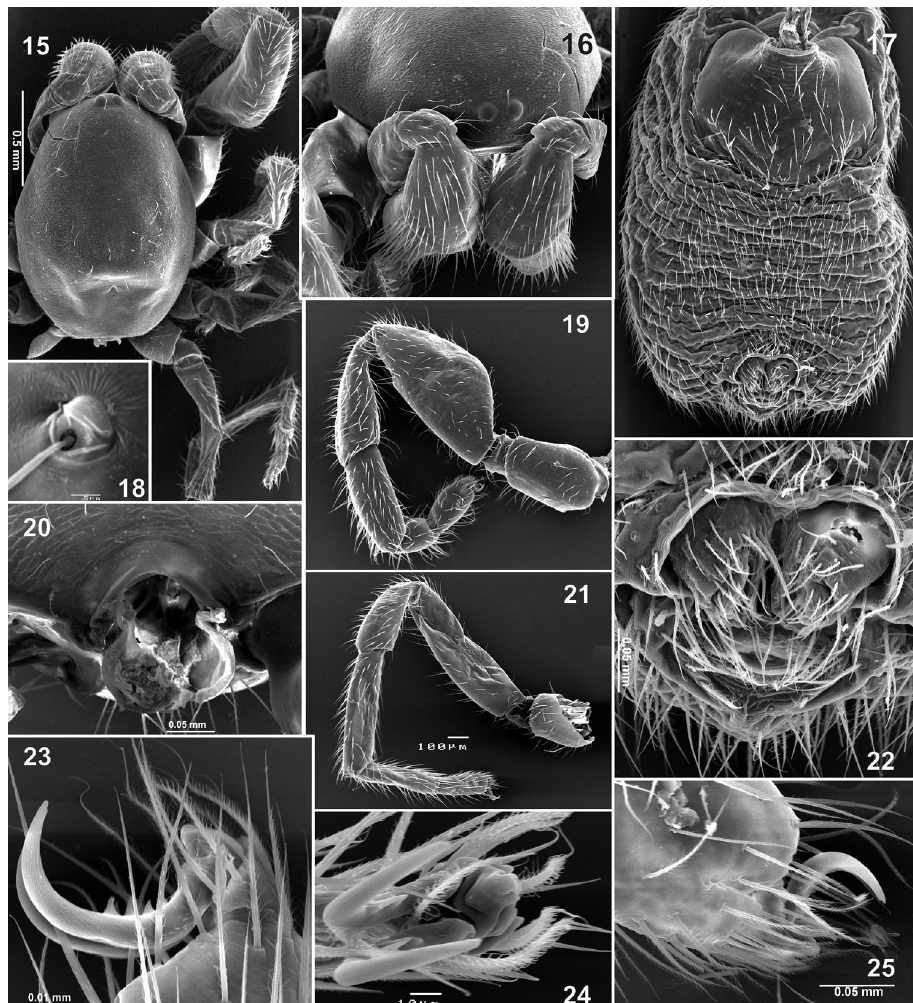
Figures 15–25. SEM micrographs of somatic morphology of subadult male of Chedimanops eskovi sp. n. 15 prosoma, dorsal 16 prosoma, frontal 17 abdomen, ventral 18 trichobothrium 19 leg I, retrolateral 20 posterior part of prosoma, caudal 21 leg, retrolateral 22 spinnerets, ventral 23–24 tarsal claws of leg IV, lateral and dorsal 25 claws of tarsus I,